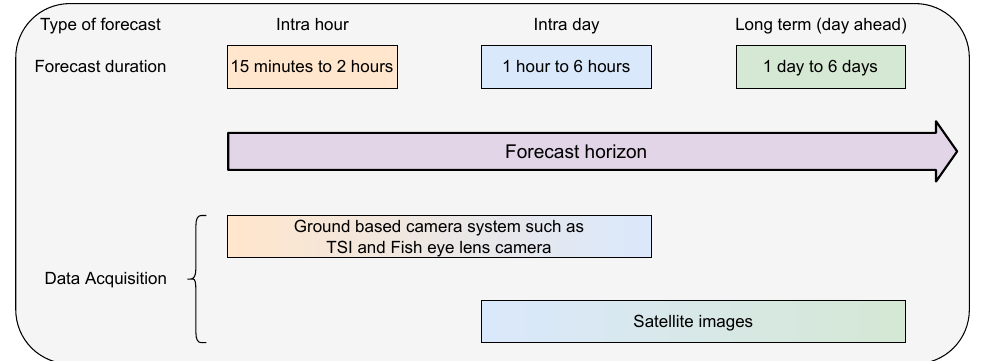
Figure 1. Forecast horizon, related methods and imaging systems